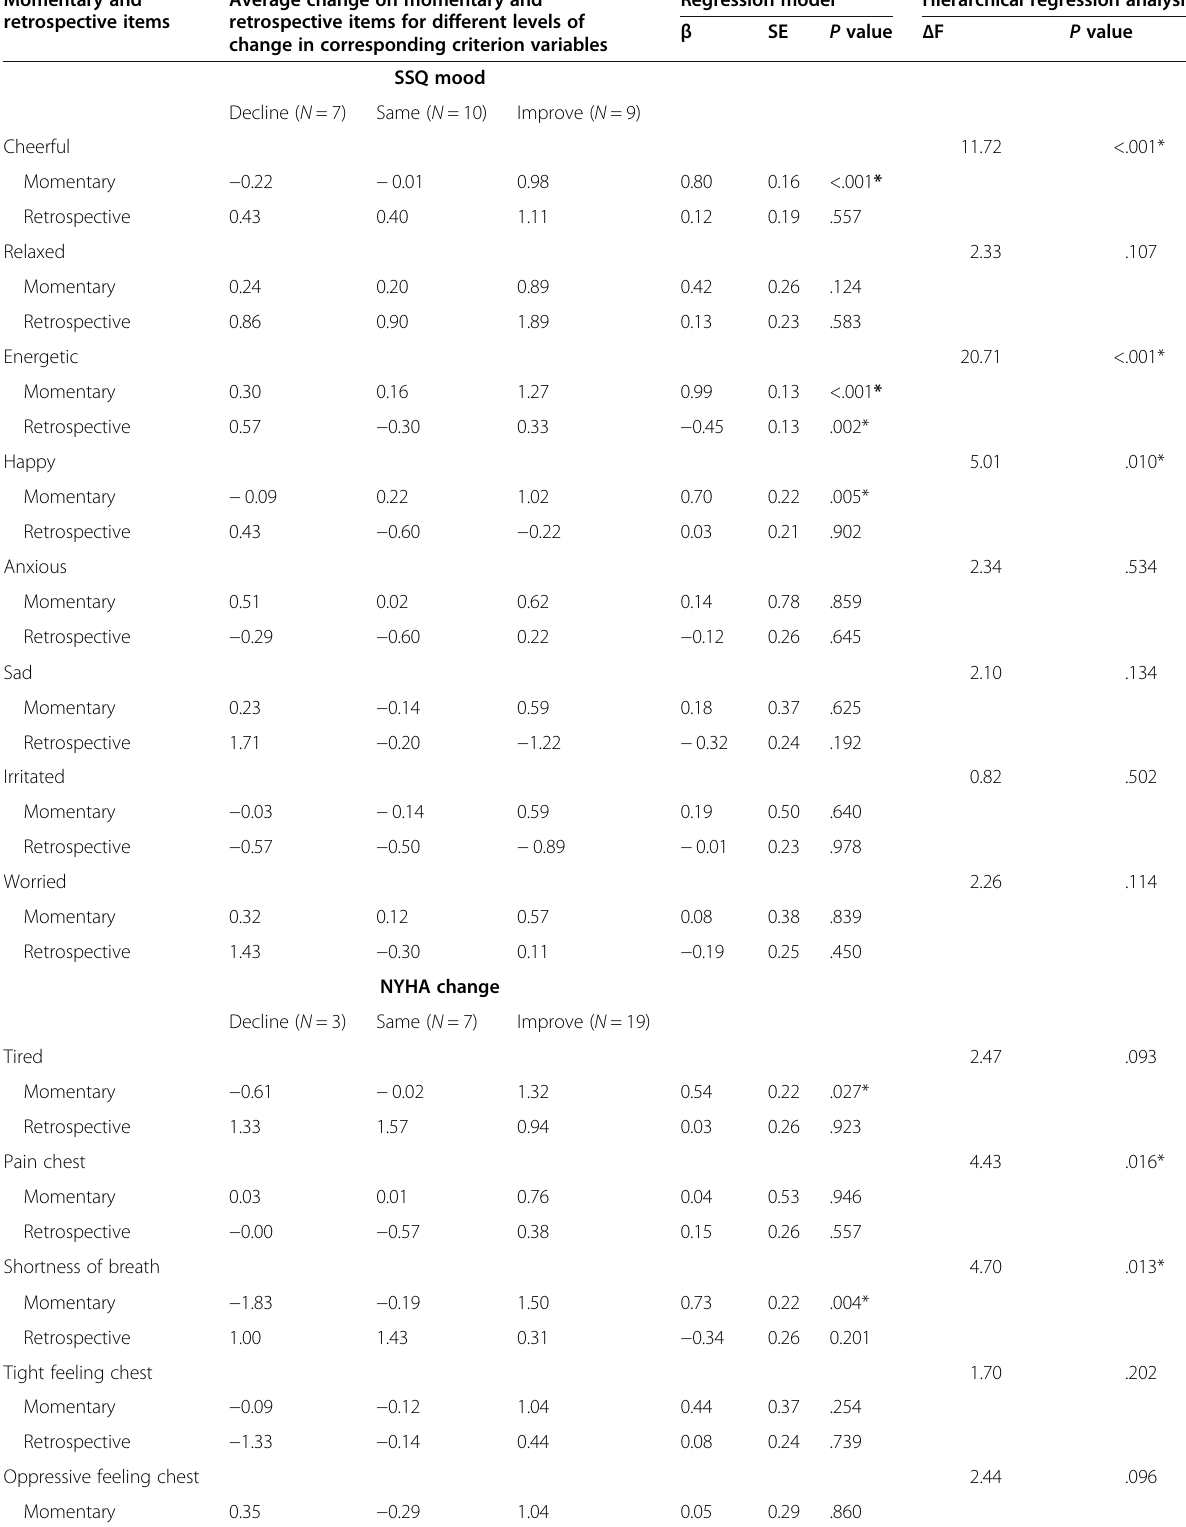
Table 2 Associations between changes in momentary and retrospective items with the criterion measures of change ( N = 26 at baseline and